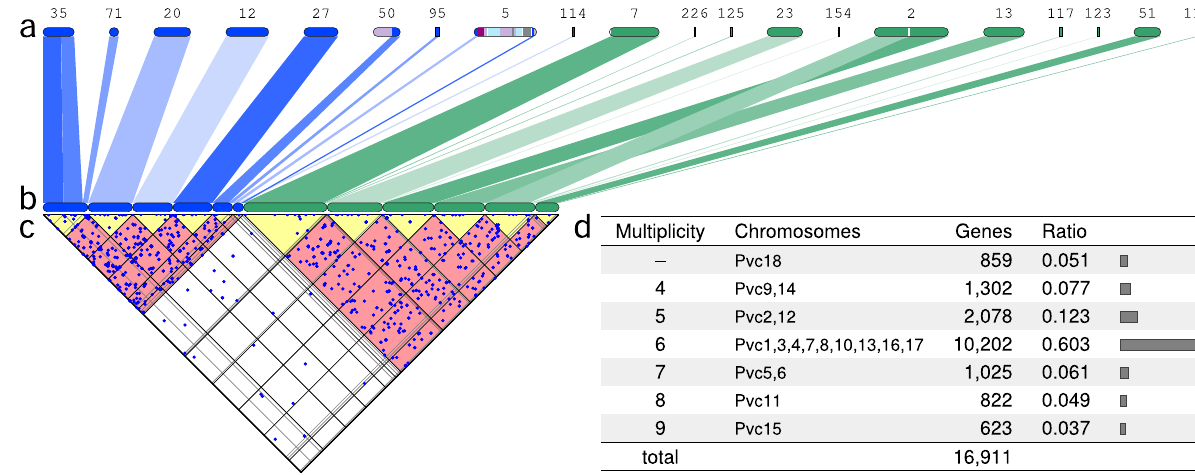
Fig. 3 Reconstruction of the proto-cyclostome chromosomes and evidence of sixfold duplication of the genome. a Japanese lamprey scaffolds are illustrated with the scaffold IDs. These scaffolds were partitioned into segments of conserved synteny, and segments corresponding to proto-vertebrate chromosome Pvc3 (blue) and Pvc17 (green) are shown for illustrative purposes. b Groups of segments of the same colour were organized into several subgroups representing proto-cyclostome chromosomes based on the distribution of paralogues and orthologues. c The triangular plot is a 45°-rotated graph of the paralogue distribution between the 12 proto-cyclostome chromosomes that correspond to Pvc3 and Pvc17. This shows large numbers of paralogues between the chromosomes (dots in the red regions) but few paralogues within each chromosome (dots in the yellow regions). d The table classi fi es the proto-vertebrate chromosomes with respect to the number of duplicated proto-cyclostome chromosomes as shown in the ‘ Multiplicity' column (Pvc18 was retained as a single proto-cyclostome chromosome because Pvc18 had too many segments for the reconstruction algorithm). The table also shows the numbers and ratios of Japanese lamprey genes that were mapped to the proto-cyclostome chromosomes originating from the proto- vertebrate chromosomes shown in the ‘ Chromosomes'